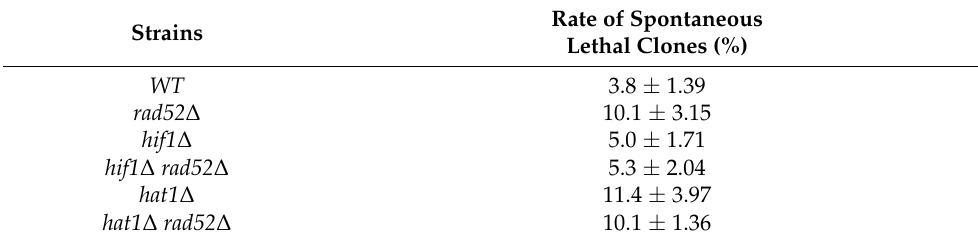
Table 2. Rate of spontaneous lethal clones after 1 day of incubation on a dense nutrient medium.